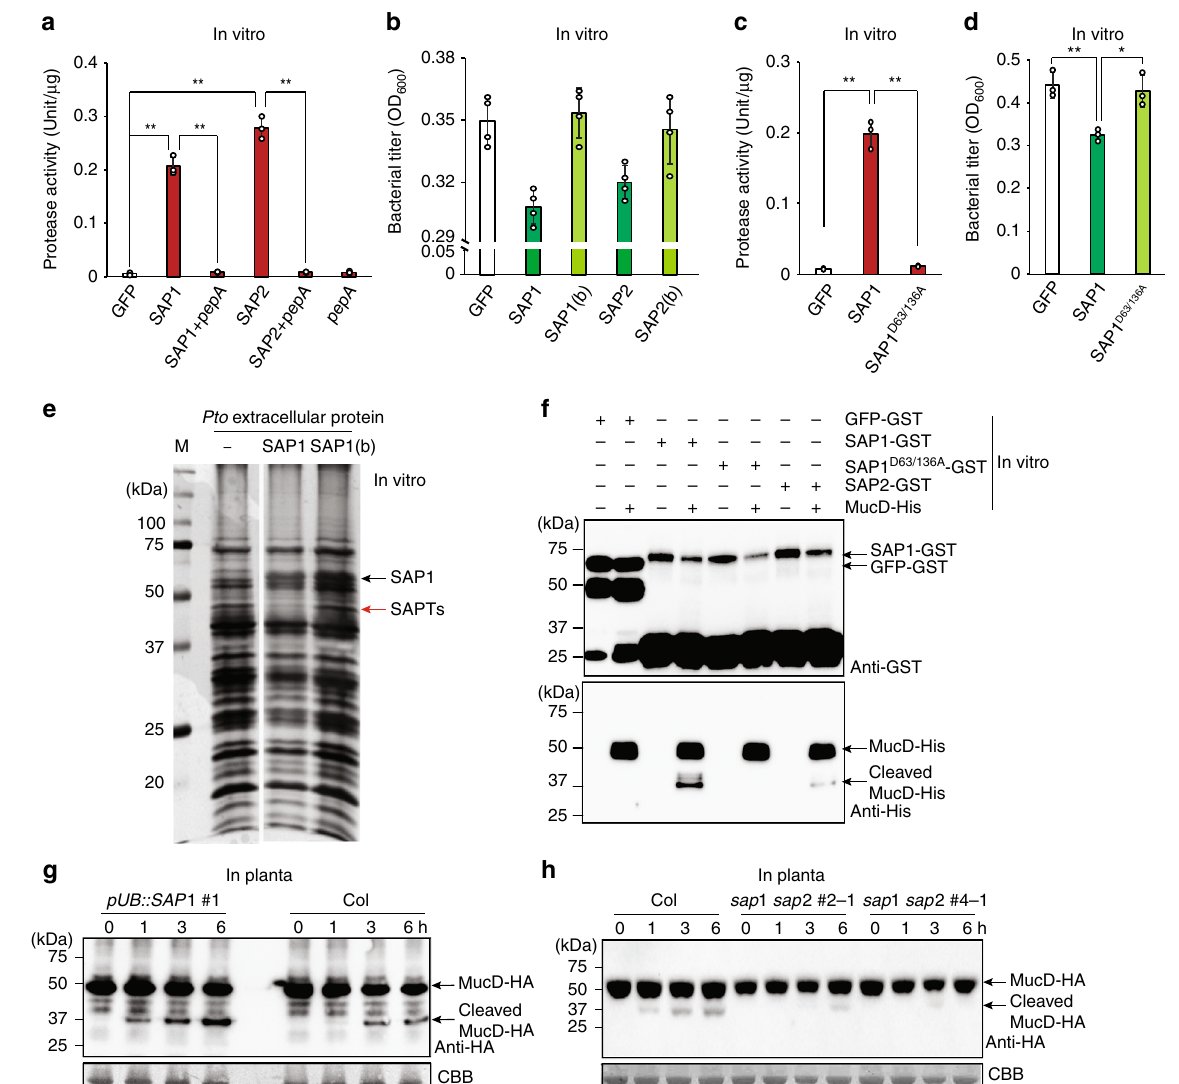
Fig. 3 Secreted aspartic protease 1 (SAP1) and SAP2 cleave MucD. a , c Protease activity of puri fi ed GFP (green fl uorescent protein), SAP1, SAP2 ( a ), and SAP1 D63/136A ( c ) protein. PepA, the aspartic protease inhibitor, pepstatin A. Data represent means and s.e.m of three biological replicates. Asterisks indicate signi fi cant differences (Student ’ s two-tailed t test; ** P < 0.01). b , d In vitro growth of Pto (OD 600 = 0.05) in minimal medium supplemented with puri fi ed recombinant proteins or boiled (b) recombinant proteins at 9 h after culturing. Data represent means and s.e.m. of four biological replicates. Asterisks indicate signi fi cant differences (Student ’ s two-tailed t ; * P < 0.05, ** P < 0.01). e Proteins extracted from bacterial culture medium incubated with SAP1, boiled SAP1 (SAP1(b)), or without SAP were visualized (Coomassie Brilliant Blue (CBB) staining). f MucD-His incubated with SAP1-GST, SAP1 D63/136A -GST, and SAP2-GST were visualized by immunoblotting using an anti-GST or anti-His antibody. Three independent experiments were performed with similar results. g , h Pto Δ mucD expressing MucD-HA (hemagglutinin) (OD 600 = 0.05) was in fi ltrated into leaves of 4-week-old Col, pUB:: SAP1-RFP , and sap1 sap2 plants. MucD-HA in total protein at the indicated time points was detected by immunoblotting using an anti-HA antibody. CBB staining serves as protein loading control. Experiments were repeated at least three times with similar